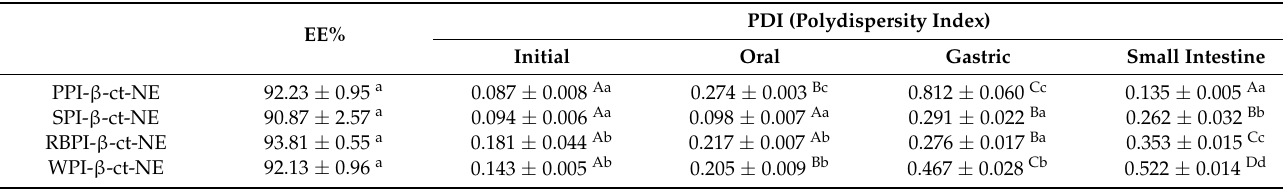
Table 1. The encapsulation efficiency (EE) of β -carotene and polydispersity indices (PDI) in different digestion stages for the peanut protein isolate (PPI)-, soy protein isolate (SPI)-, rice bran protein isolate (RBPI)-, and whey protein isolate (WPI)-stabilized nanoemulsions (PPI- β -ct-NE, SPI- β -ct-NE, RBPI- β -ct-NE, WPI- β